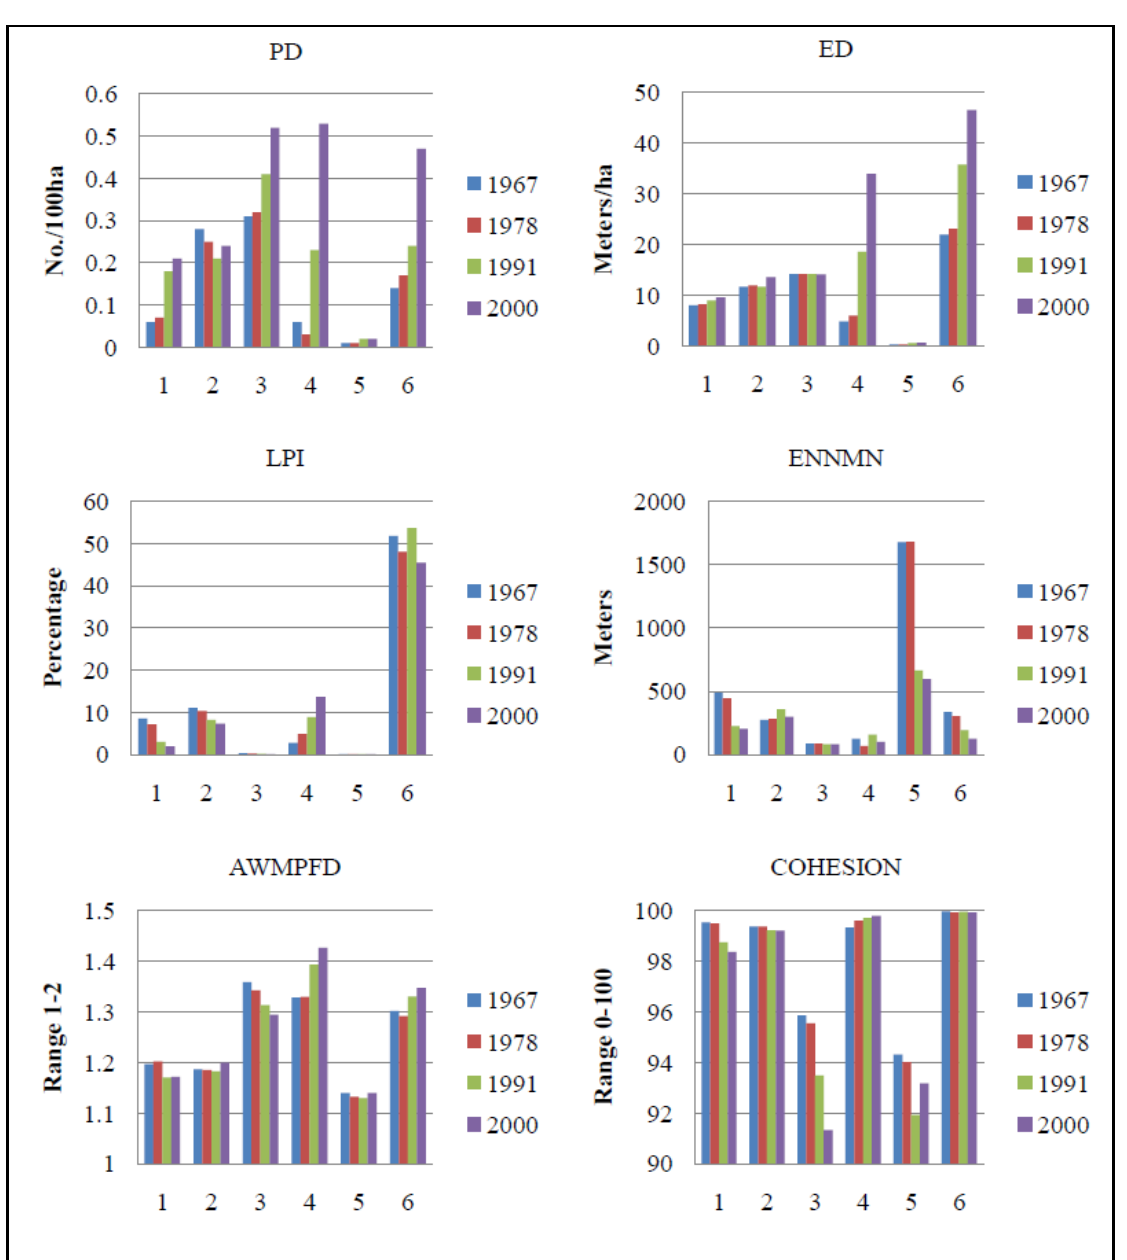
Figure 9. Spatial metrics at class